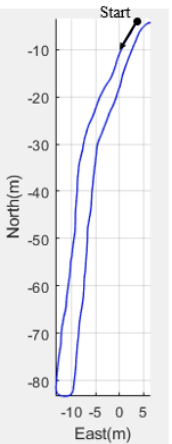
Figure 3. The path trajectory of the underground parking lot.